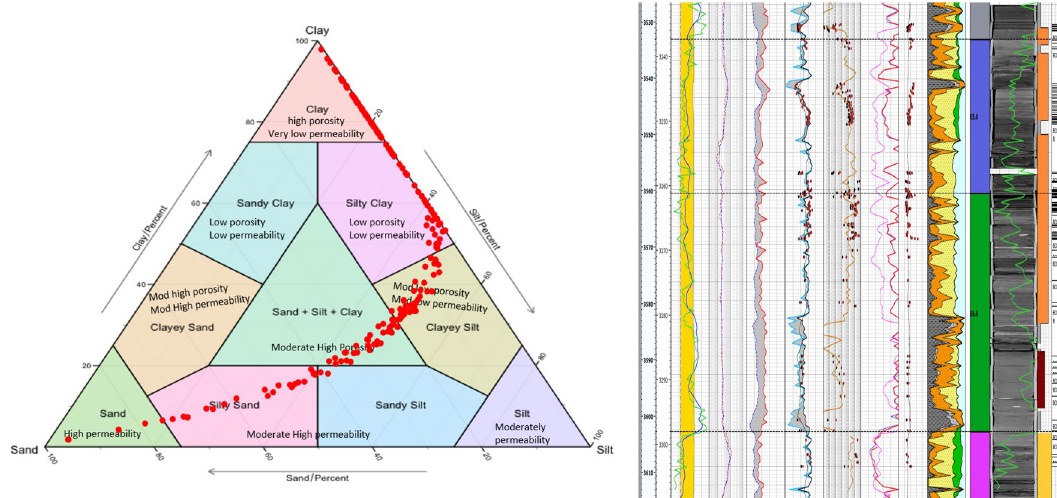
Fig. 13 Ternary diagram for the cored interval in the study well